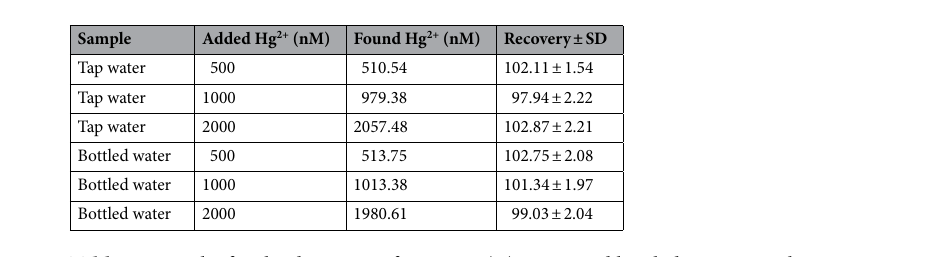
Table 2. Results for the detection of mercury (II) in tap and bottled water samples.